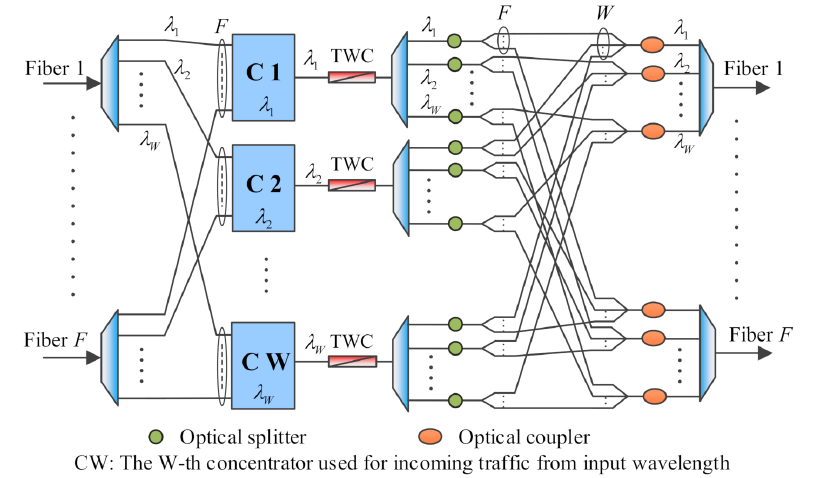
Figure 1. The proposed OPS architecture with input